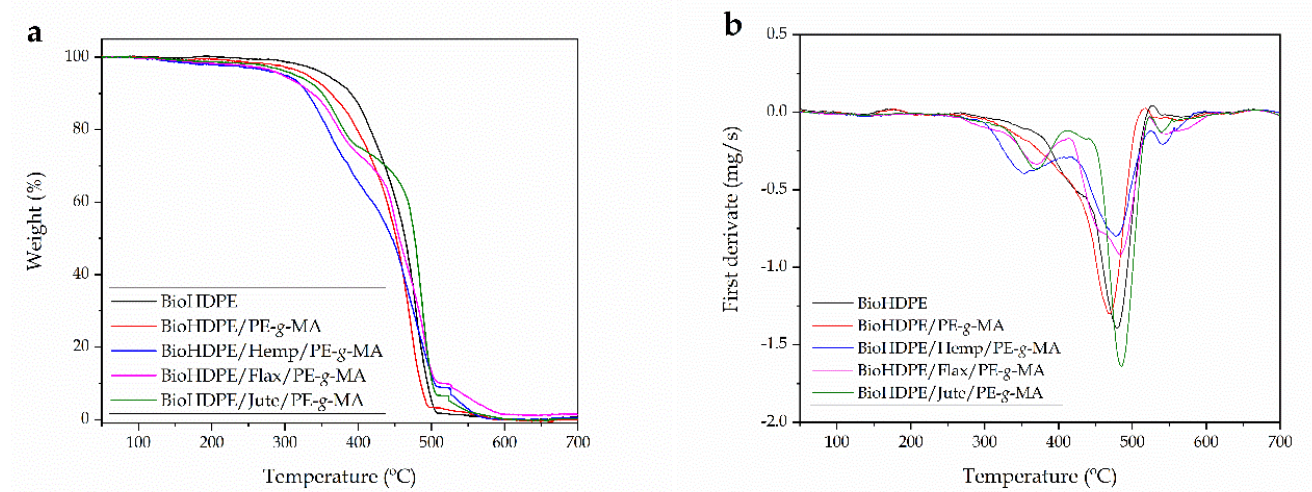
Figure 6. Thermal degradation of BioHDPE composites with different natural fibers, ( a ) thermogravimetric (TGA) curves and ( b ) first derivative (DTG) curves. Table 4. Main thermal degradation parameters of the samples of Bio-HDPE with different natural fibers in terms of: temperature at mass loss of 5% (T 5% ), degradation temperature (T deg ), and resid- ual mass at 700 °C.